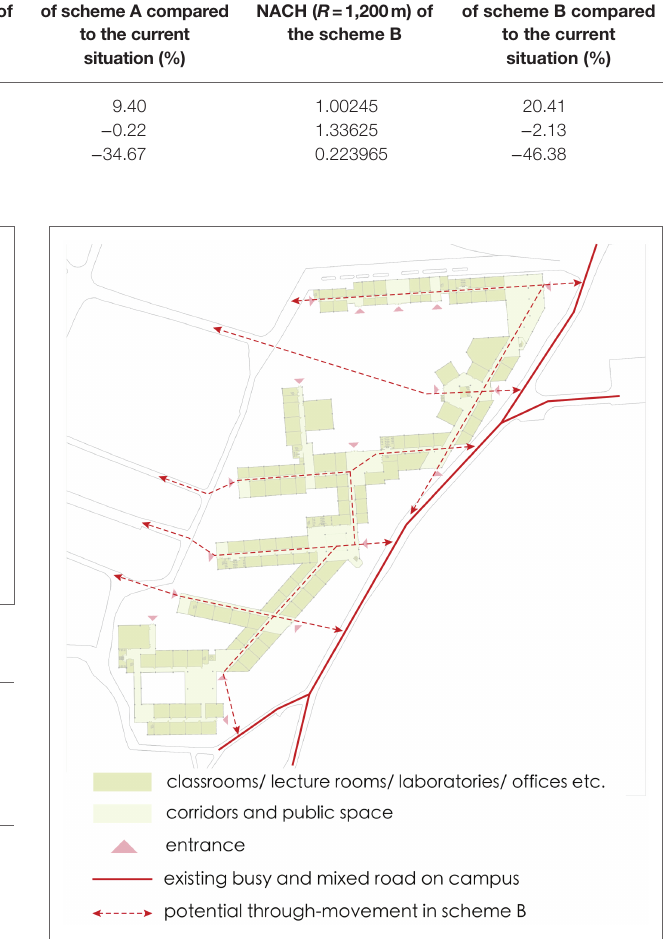
FIGURE 9 | Scheme B organizing the through-movement based on the existing busy road.